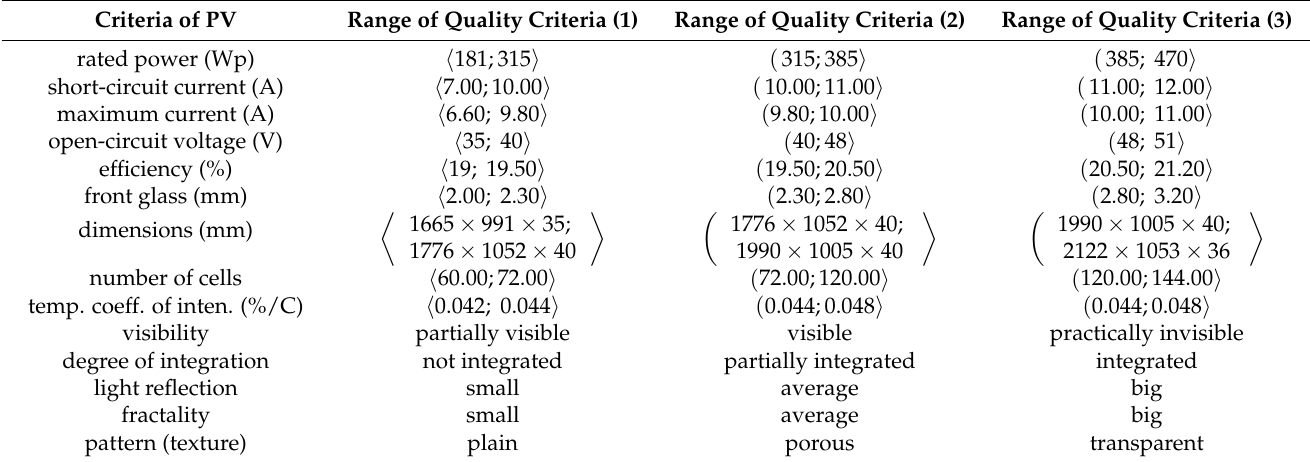
Table 1. Characteristics of PV criteria states. Own study.